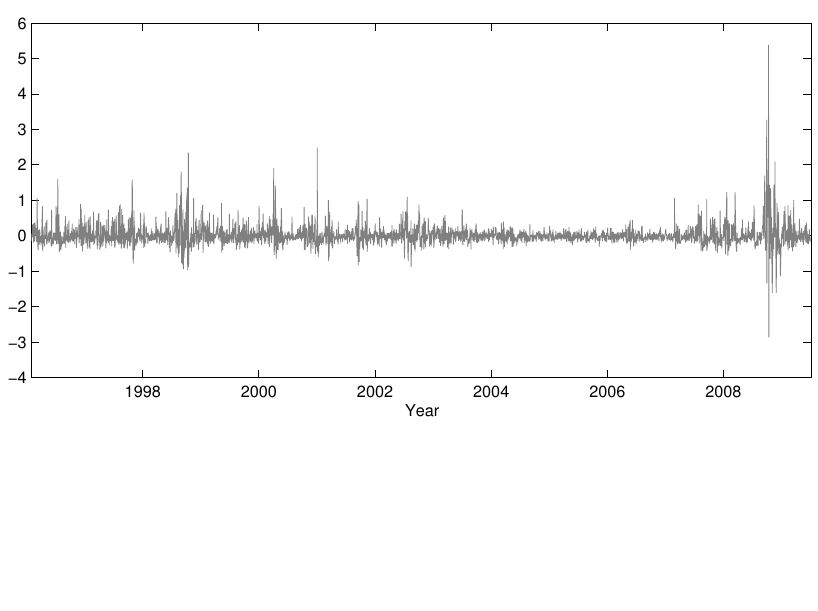
Figure 4. Residuals series of the HAR model with leverage